Question: Describe this figure in one sentence.
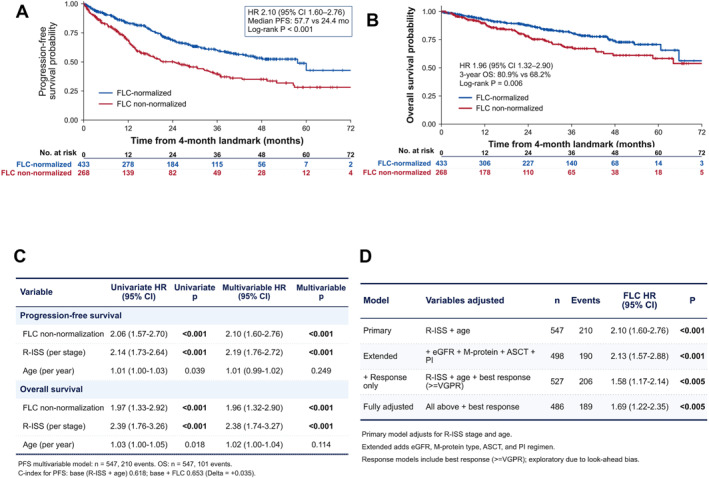
Answer: FLC ratio normalization is associated with progression‐free survival and overall survival. (A) PFS and (B) OS stratified by FLC normalization status during C1–C4 (FLC‐normalized, n = 433; FLC non‐normalized, n = 268). Median PFS: 57.7 versus 24.4 months (log‐rank p < 0.001). Three‐year OS: 80.9% versus 68.2% ( p = 0.006). Time measured from the 4‐month landmark. (C) Univariable and multivariable Cox proportional hazards analysis for PFS and OS, adjusting for R‐ISS stage and age ( n = 547, 210 PFS events, 101 OS events). Model discrimination (C‐index) for PFS: base model (R‐ISS + age) 0.618; base + FLC 0.653 (Δ = +0.035). (D) Extended multivariable models for PFS showing stability of FLC non‐normalization HR across progressively adjusted models: primary (R‐ISS + age, HR 2.10), extended (+eGFR, M‐protein, ASCT, PI, HR 2.13), response‐adjusted (+ best response ≥ VGPR, HR 1.58), and fully adjusted (HR 1.69). All models use PFS as the outcome with a 4‐month landmark.